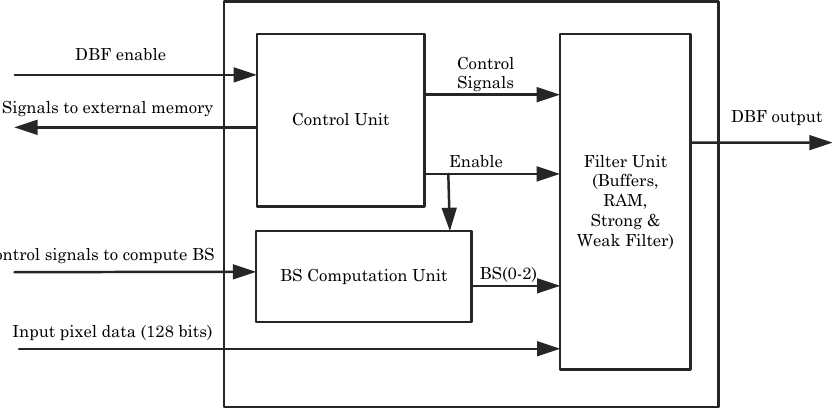
Figure 3. Architecture of V-DPEDBF for HEVC [40].